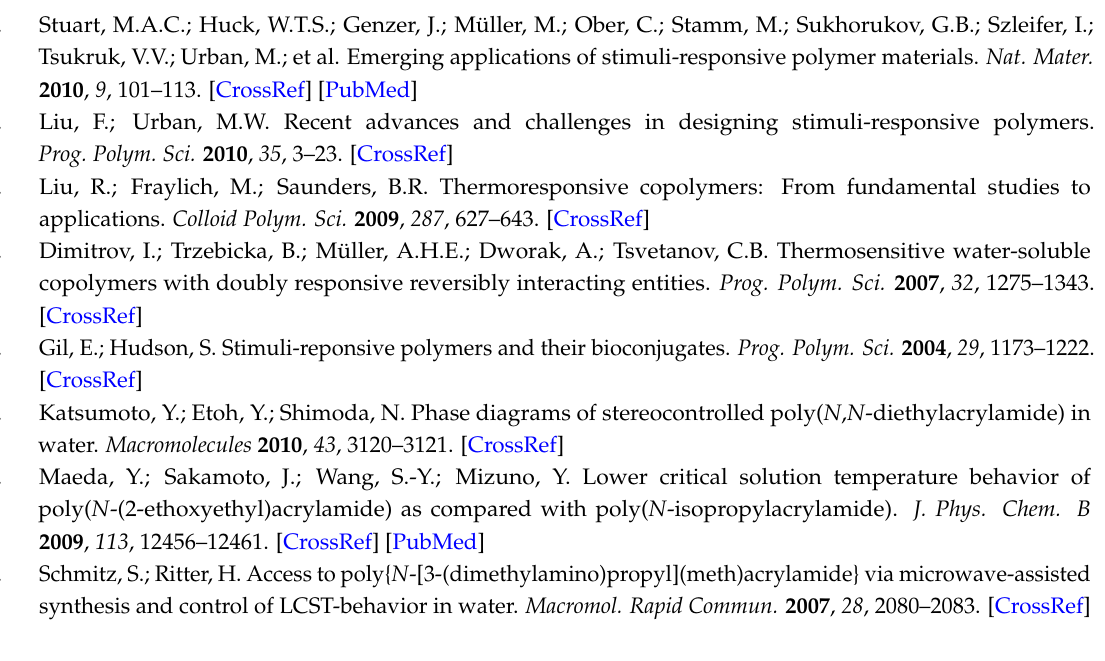
Figure S2: FT-IR spectra of C1–C6 copolymers; Figure S3: DSC traces of C1–C6 copolymers (record of 2nd heating run with ramp 20 ◦ C/min under N 2 ); Figure S4: TGA traces of C1–C6 copolymers (ramp 20 ◦ C/min under N 2 ); Figure S5: LCST behaviors scanned with different wavelength (C3 copolymer: 1